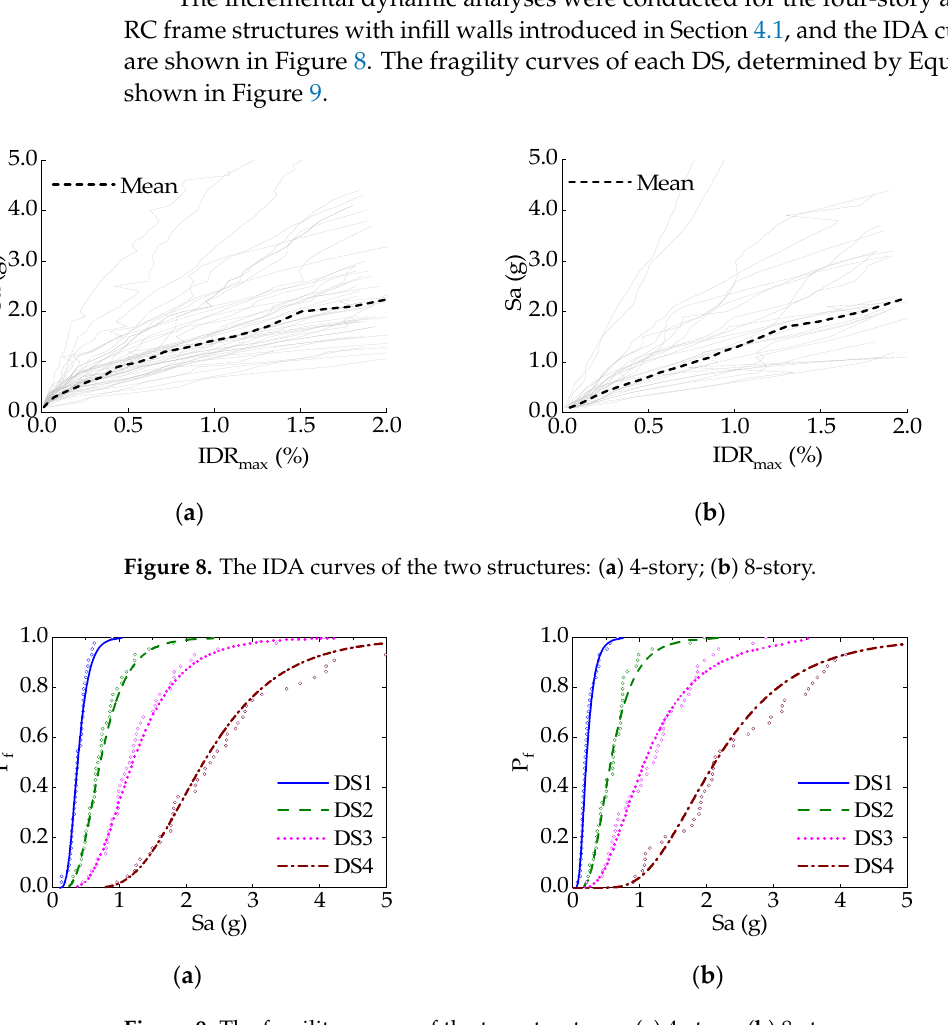
reaching DS4 was 97%, 40% and 9%, requiring Sa 4.82 g, 1.9 g and 1.2 g, respectively. The fragility curves of the structure in Figure 9 flattened as the structures reached DS1 to DS4, i.e., the probability of transcendence became progressively smaller. The DS1 curves in the figure are the steepest and the structures reached DS1 when Sa was very small, indicating that the structure could easily break through the DS1 limit to reach DS2 under a low seismic action. The DS4 curves are the flattest, which required a larger Sa for the same transcendence probability, indicating that it was difficult for the structures to reach DS4. 5. Conclusions In this paper, a definition of the damage state of infill walls loaded in an in-plane direction was developed. A corresponding performance target was proposed, which was applied to carry out a fragility analysis of two infilled RC frames. First, an extensive database of experimental tests on infilled RC frames stressed by in-plane loading was collected and presented. The in-plane damage state (DS) of infill walls was defined as four stages according to the observed damage process as well as the mechanical properties during the test. The IDR values corresponding to each DS were identified, and fitted to the lognormal distribution function. The parameters of the lognor- mal fragility functions corresponding to each DS were obtained. The mean value of the IDR was chosen as the performance target of each DS, which was 0.1%, 0.3%, 0.9% and 1.9%, respectively. Then, the proposed seismic performance targets were used to conduct a fragility analysis of two infilled wall RC frames. The probability of the four-story structure reach- ing DS1, DS2 and DS3 was 79%, 20% and 3%, respectively, when Sa was 0.5 g. However, the probability of the four-story structure reaching DS4 was 79%, 20% and 3%, requiring Sa 3.1 g, 1.6 g and 1.1 g, respectively. The results demonstrated that the infilled RC frame structures could reach DS1 and DS2 under a relatively low seismic intensity. When the seismic intensity increased, DS3 could be reached gradually. However, reaching DS4 was challenging, which required ground motion intensity several times larger. It should be noted that the conclusions obtained in this study are related to the data collected due to the empirical IDR value. In the future, more effort will be made to expand the experimental database and the out-of-plane seismic performance target of the infill